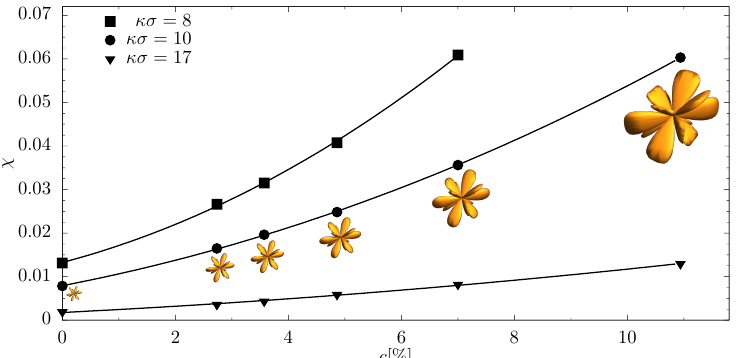
Figure 7. Degree of auxeticity with respect to the concentration for various values of screening length. The inserts in the figure show the average absolute value of negative Poisson’s ratio (Equation (9)) in all crystallographic directions for κσ = 10. The surface consists of the points that represent R ( θ , φ ) . All the inserted figures are presented at the same